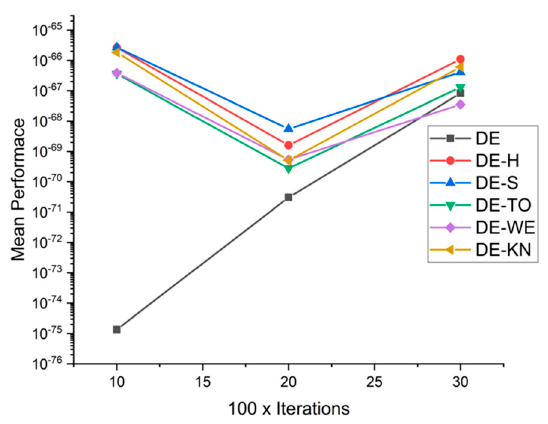
Figure 31. Convergence curve on fn9.